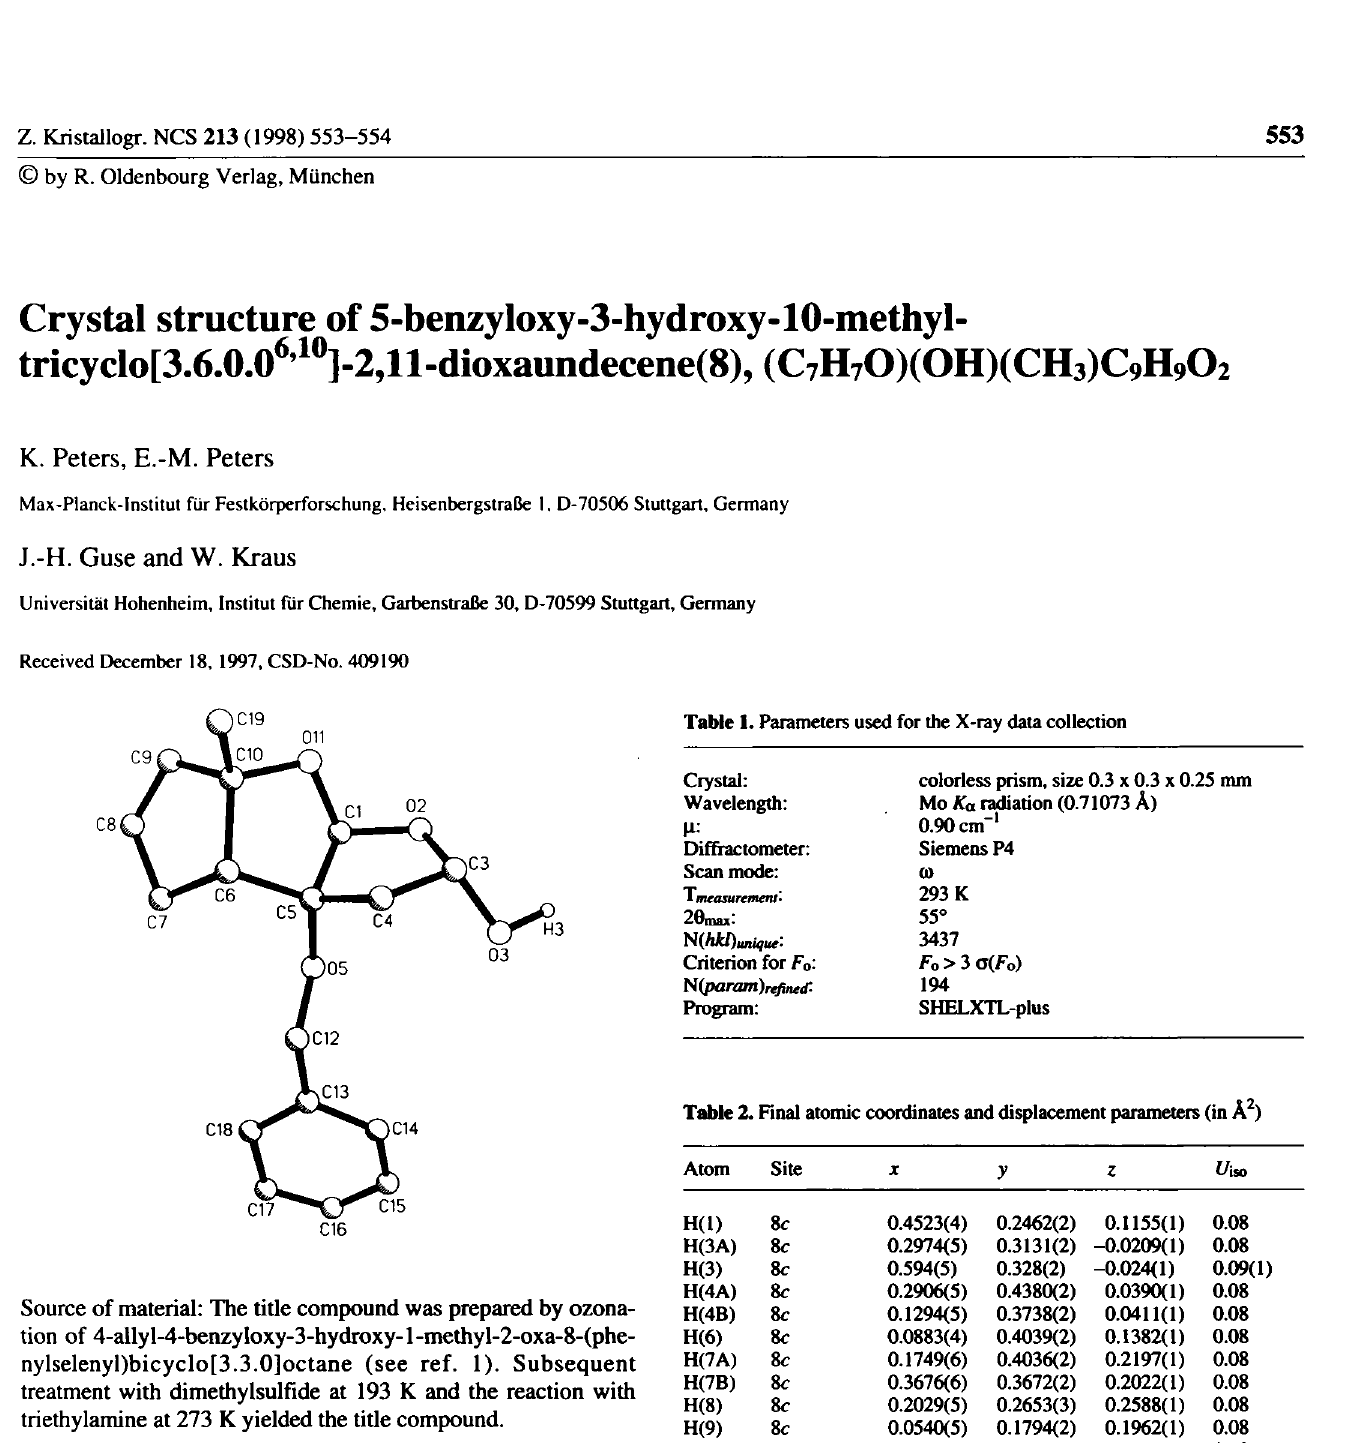
Table 2. Fmal atomic coordinates and displacement parameters (in Â^)